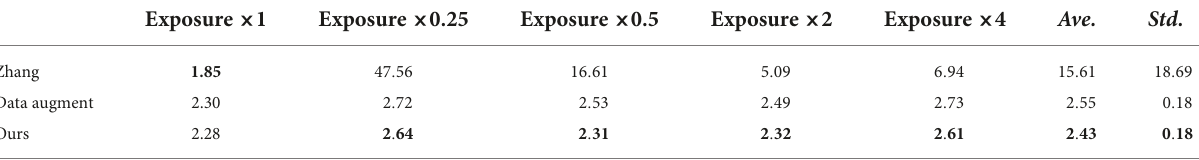
TABLE 6 Comparison of mean relative absolute error (MRAE) (%) of different optimization methods under different tested exposure levels. Exposure × 1